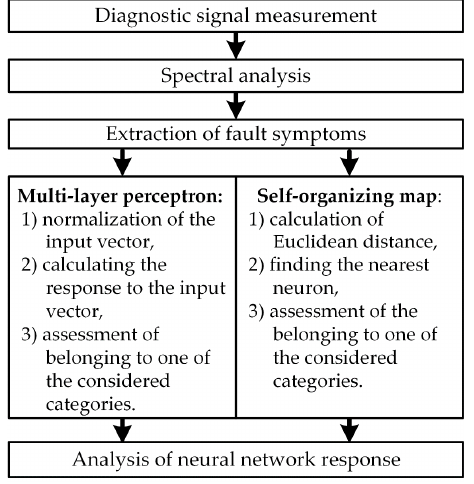
Figure 3. The illustration of the PMSM damage-detection process using shallow neural network.